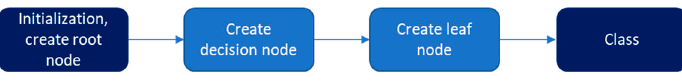
Figure 3. Indicative example of DT steps.